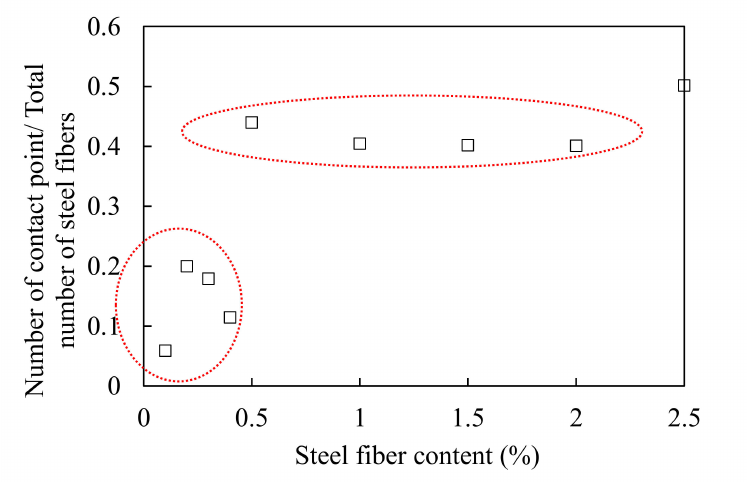
Figure 12. Plot of number of contact points divided by total number of steel fibers as a function of steel fiber